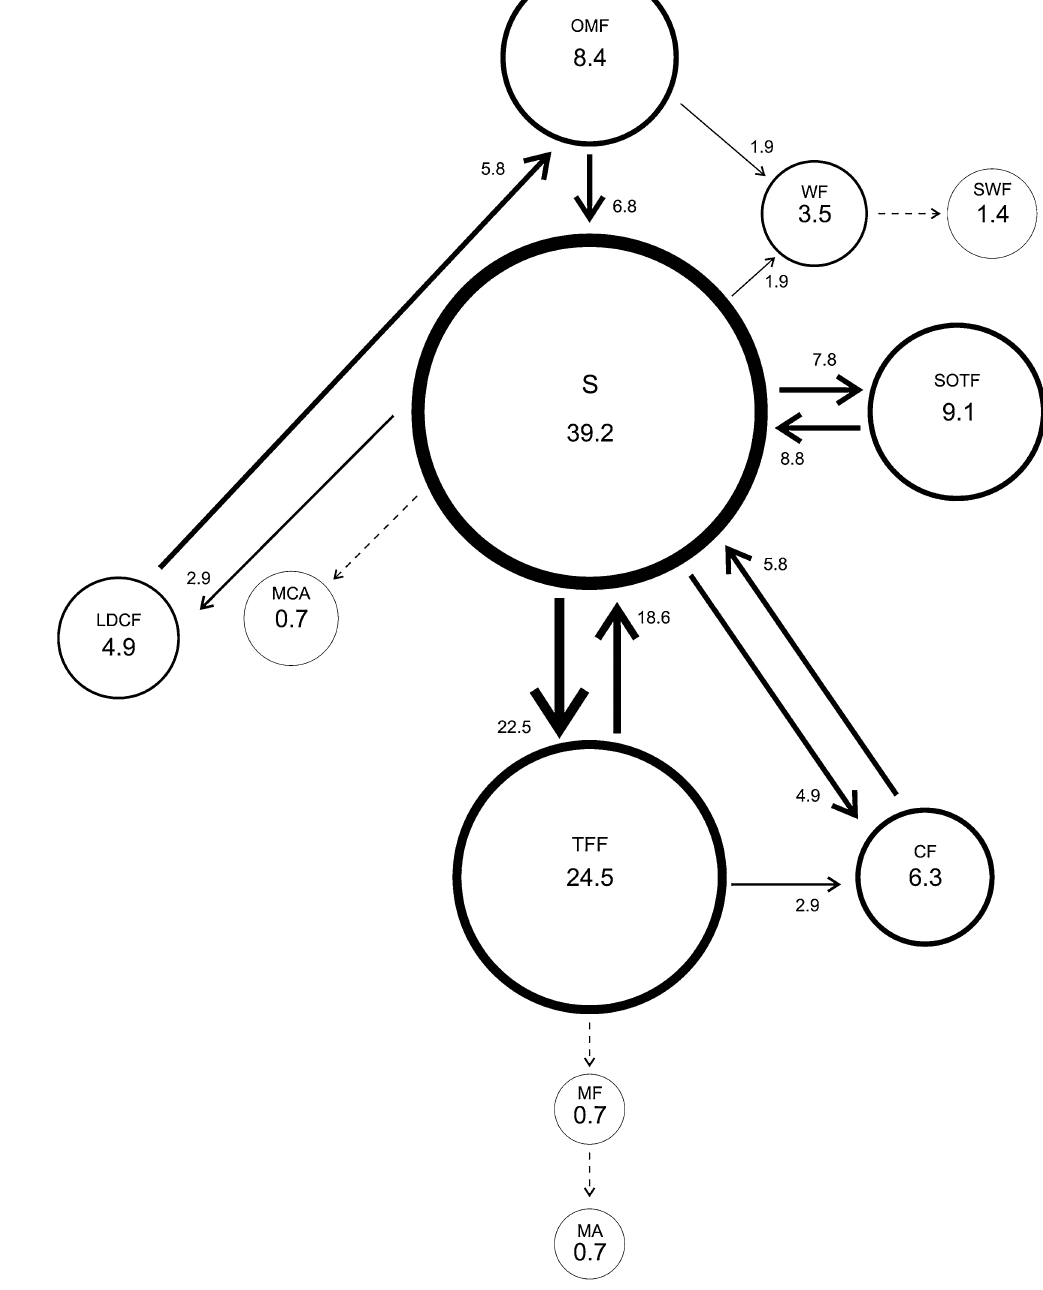
male would court the female most of the time and the subordinate males remained away from the dominant male and the female. When the subordinate male had the opportunity to get close to the female, he performed “Orientation and Movement to the female” and swing his body, but the dominant male would chase him away either by threat, punching or pushing or by courting the female and moving her away from the subordinate male. When comparing the courtship behavioral elements frequency, dominant males performed “Touches Female with Forelegs” significantly more times than subordinate males (Table 4). Similarly, dominant males transited “Touches Female with Forelegs-Swing of the body laterally” significantly more times than subordinate males (Table 5).